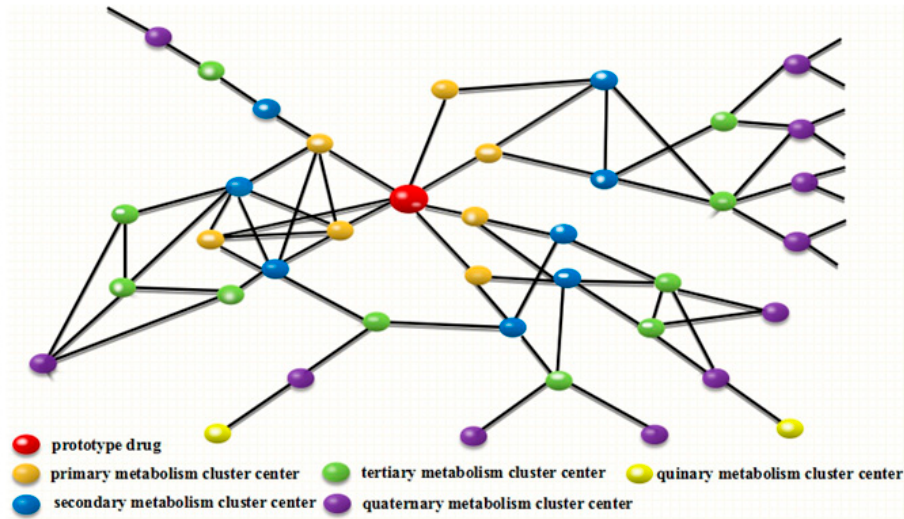
Figure 1. Creation and visualization of drug metabolite clusters (DMCs). The DMCs are constructed from the alignment of metabolite cluster centers to one another. Edges connecting nodes are defined by the MS/MS spectra that determine the relation of two metabolites. With centers stepwise increasing, metabolite clusters have increasingly developed and even intersect among every cluster.